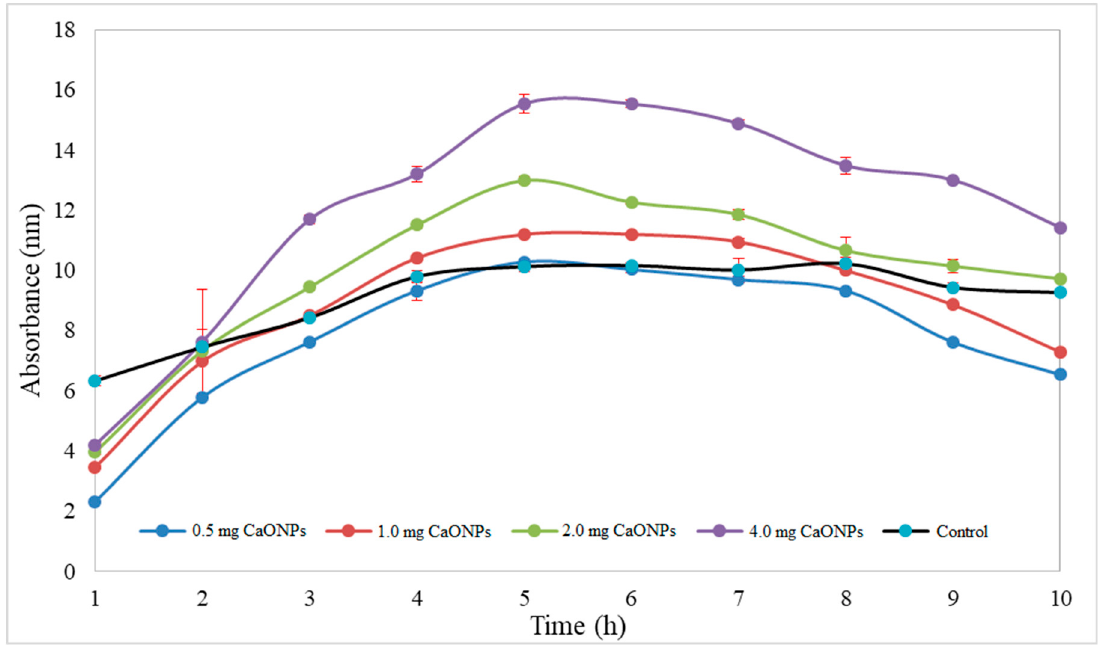
Figure 6. In vitro release of calcium oxide nonoparticles. Data are expressed as mean ± Standard error of means (n = 3).